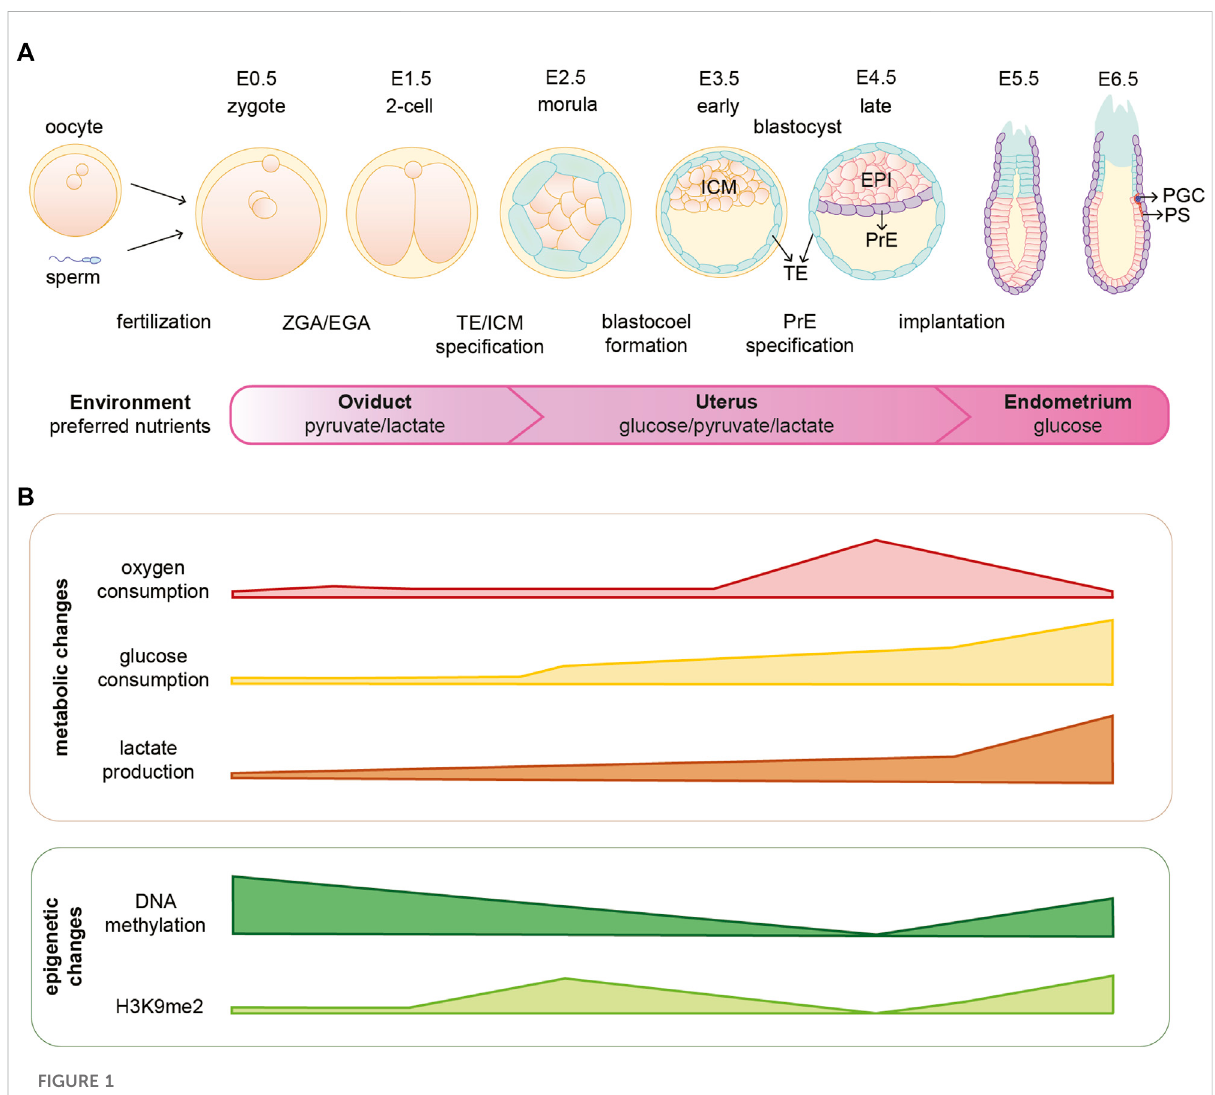
FIGURE 1 Mouse embryonic development is coordinated with metabolic and epigenetic changes. (A) Schematic illustration of early mouse embryogenesis from fertilization until implantation (E0.5-E6.5) and crucial developmental events. The embryo moves through different environments within the female reproductive system and several metabolites are essential for embryo development in different stages. (B) Oxygen availability and consumption vary depending on the stage of embryonic development. Furthermore, the embryo undergoes metabolic and epigenetic reprogramming during the fi rst days of development. EPI, epiblast; H3K9me2, dimethylation of histone H3 lysine 9; ICM, inner cell mass; PGC, primordial germ cells; PrE, primitive endoderm; PS, primitive streak; TE, trophectoderm; ZGA/EGA, zygotic genome activation/embryonic genome